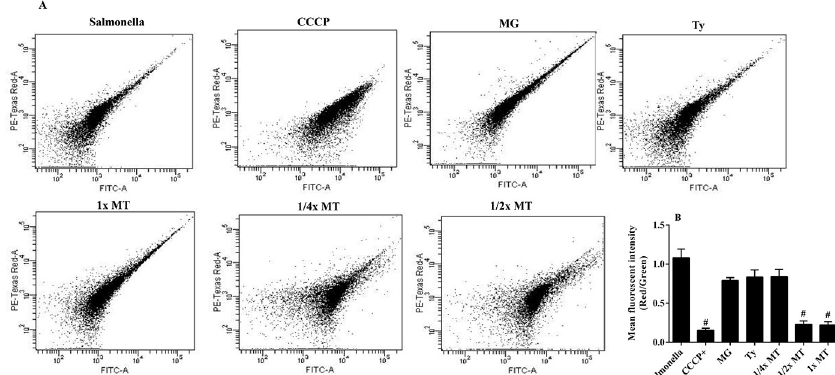
Fig 4. Effect of treatment with methyl gallate (MG), tylosin (Ty) and various concentrations of their combination (MT) on the membrane potential of S . Typhimurium (ATCC 14028). The flow cytometry depicts cells exhibiting both fluorescence intensities ( A ). The membrane potential (red-to-green fluorescent ratio) of S . Typhimurium treated with various agents, including the well-known depolarizing agent, carbonyl cyanide 3-chlorophenylhydrazone (CCCP) ( B ). # P < 0.001 compared to both MG and Ty. Salmonella : non-treated S . Typhimurium. MG = 128 μ g/mL; Ty = 256 μ g/mL; ¼× MT = 32 μ g/mL MG and 64 μ g/mL Ty; ½× MT = 64 μ g/mL MG and 128 μ g/mL Ty; and 1 × MT = 128 μ g/mL MG and 256 μ g/mL